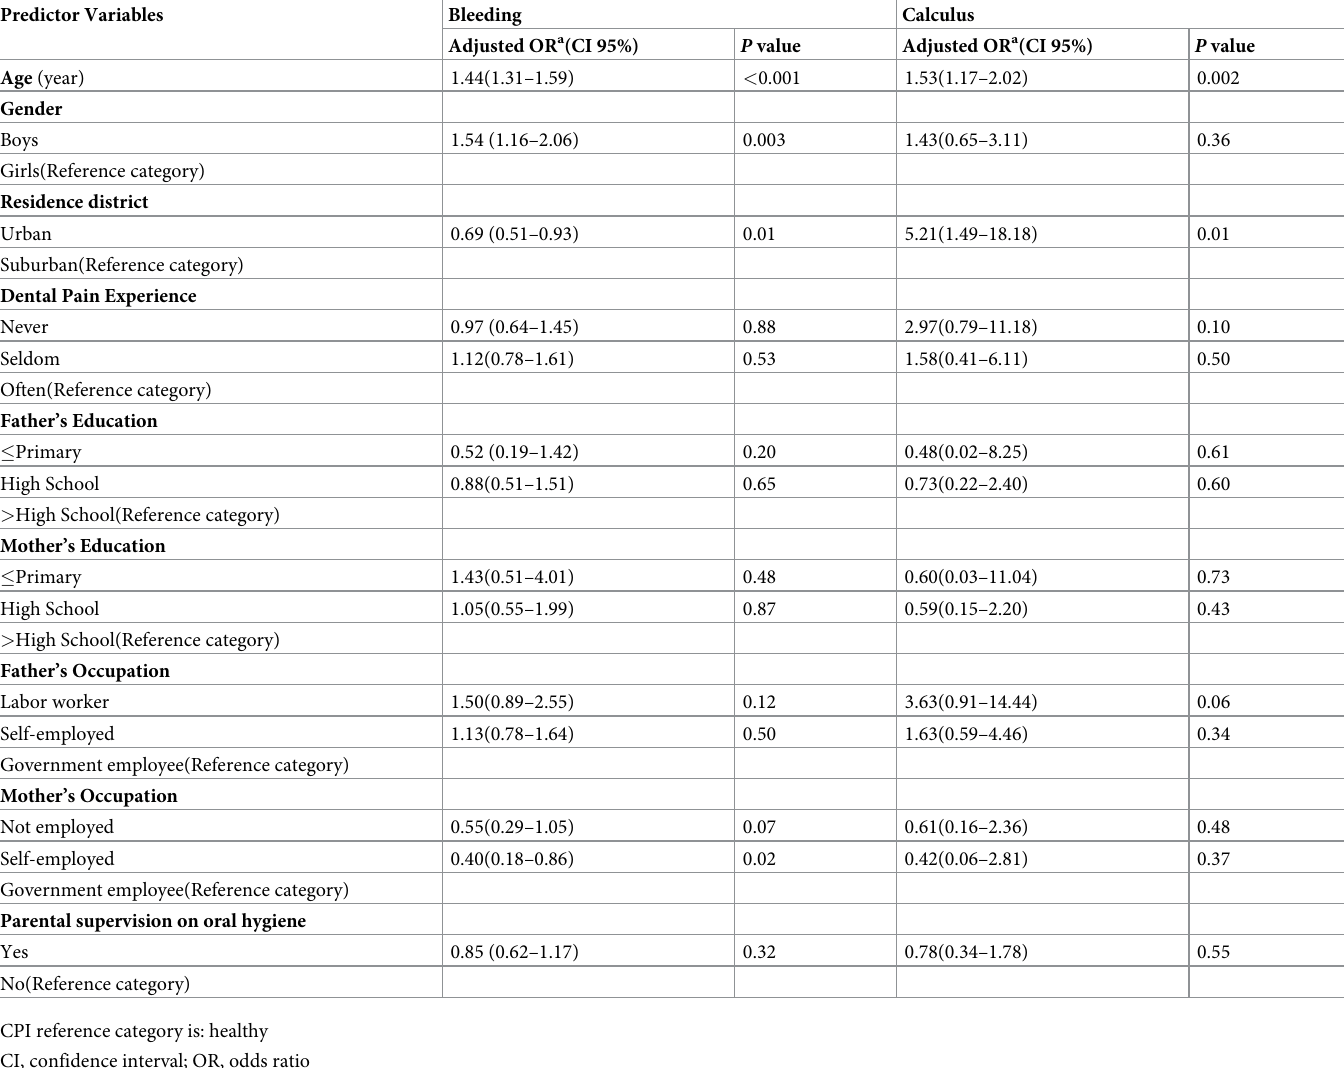
Table 2. Association between socio-demographic factors and CPI according to multinomial logistic regression analysis. Predictor